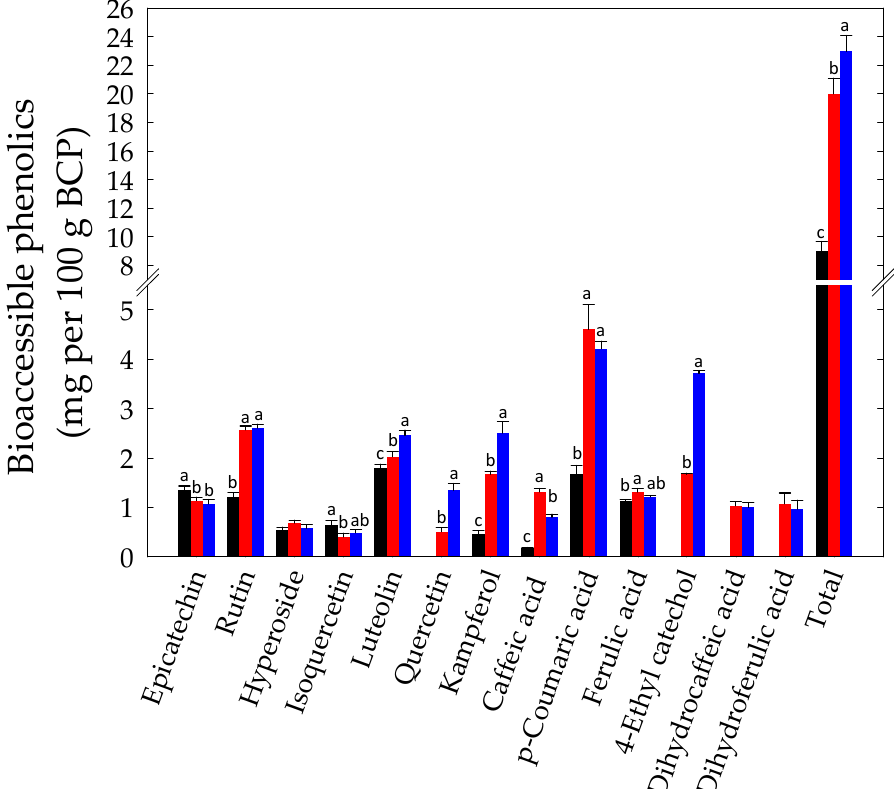
Figure 7. Bioaccessible phenolic compounds (mg per 100 g BCP) identified in Raw- (black bars), Unstarted- (blue bars), and Started-BCP (red bars). Total phenolics were calculated as the sum of individual compounds as detected by HPLC/UHPLC-ESI-MS/MS. Data are the means ( ± SD) of three independent experiments analyzed in triplicate. Data were subjected to one-way ANOVA; pair-comparison of treatment means was achieved by Tukey’s procedure at p < 0.05. For each compound, bars with different superscript letters differ significantly ( p < 0.05).